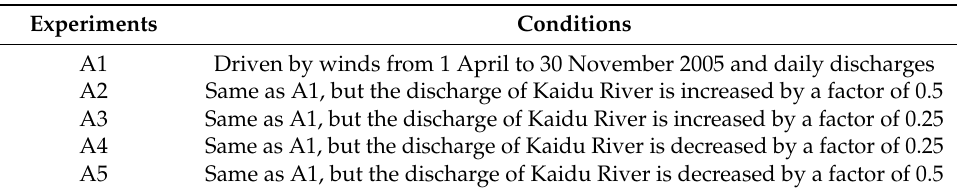
Table 1. Model experiments and their conditions.